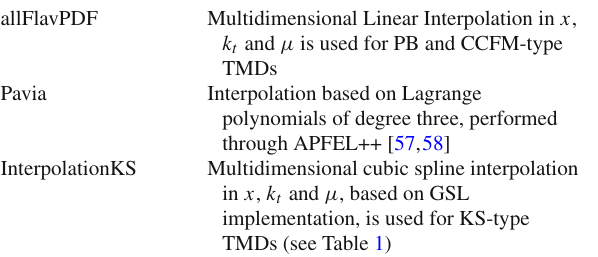
ate tools for interpolation between the grid points (where the type of evolution is